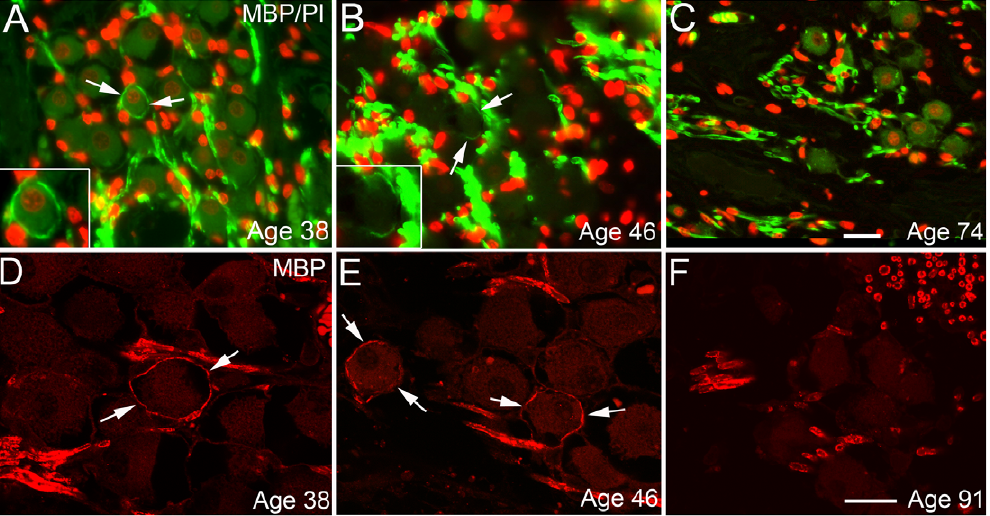
Figure 7. Age-related changes in MBP expression in human ears. A–B: A thin MBP + myelin layer (arrows) around the perikarya of some type I neurons in both the middle ( A ) and basal ( B ) turns of ears from middle-aged donors. The inset in A shows a type I neuron with an intact MBP + myelin layer at higher magnification. C : A MBP + myelin layer was not observed enveloping any neurons in a mid-modiolar section taken from a 74-year-old donor. There was also a marked loss of MBP + fibers between neurons and a reduction in the number of PI + glial cell nuclei, relative to the middle- aged specimens. D, E: Confocal images of the MBP + myelin layer (arrows) around the perikarya of some type I neurons in the spiral ganglion from a 38-year-old and a 46-year-old donor. F: A MBP + myelin layer was not observed in a mid-modiolar section taken from a 91-year-old donor. Scale bar, 12 m m in C (applies to A–C ); 12 m m in F (applies to D–F ).